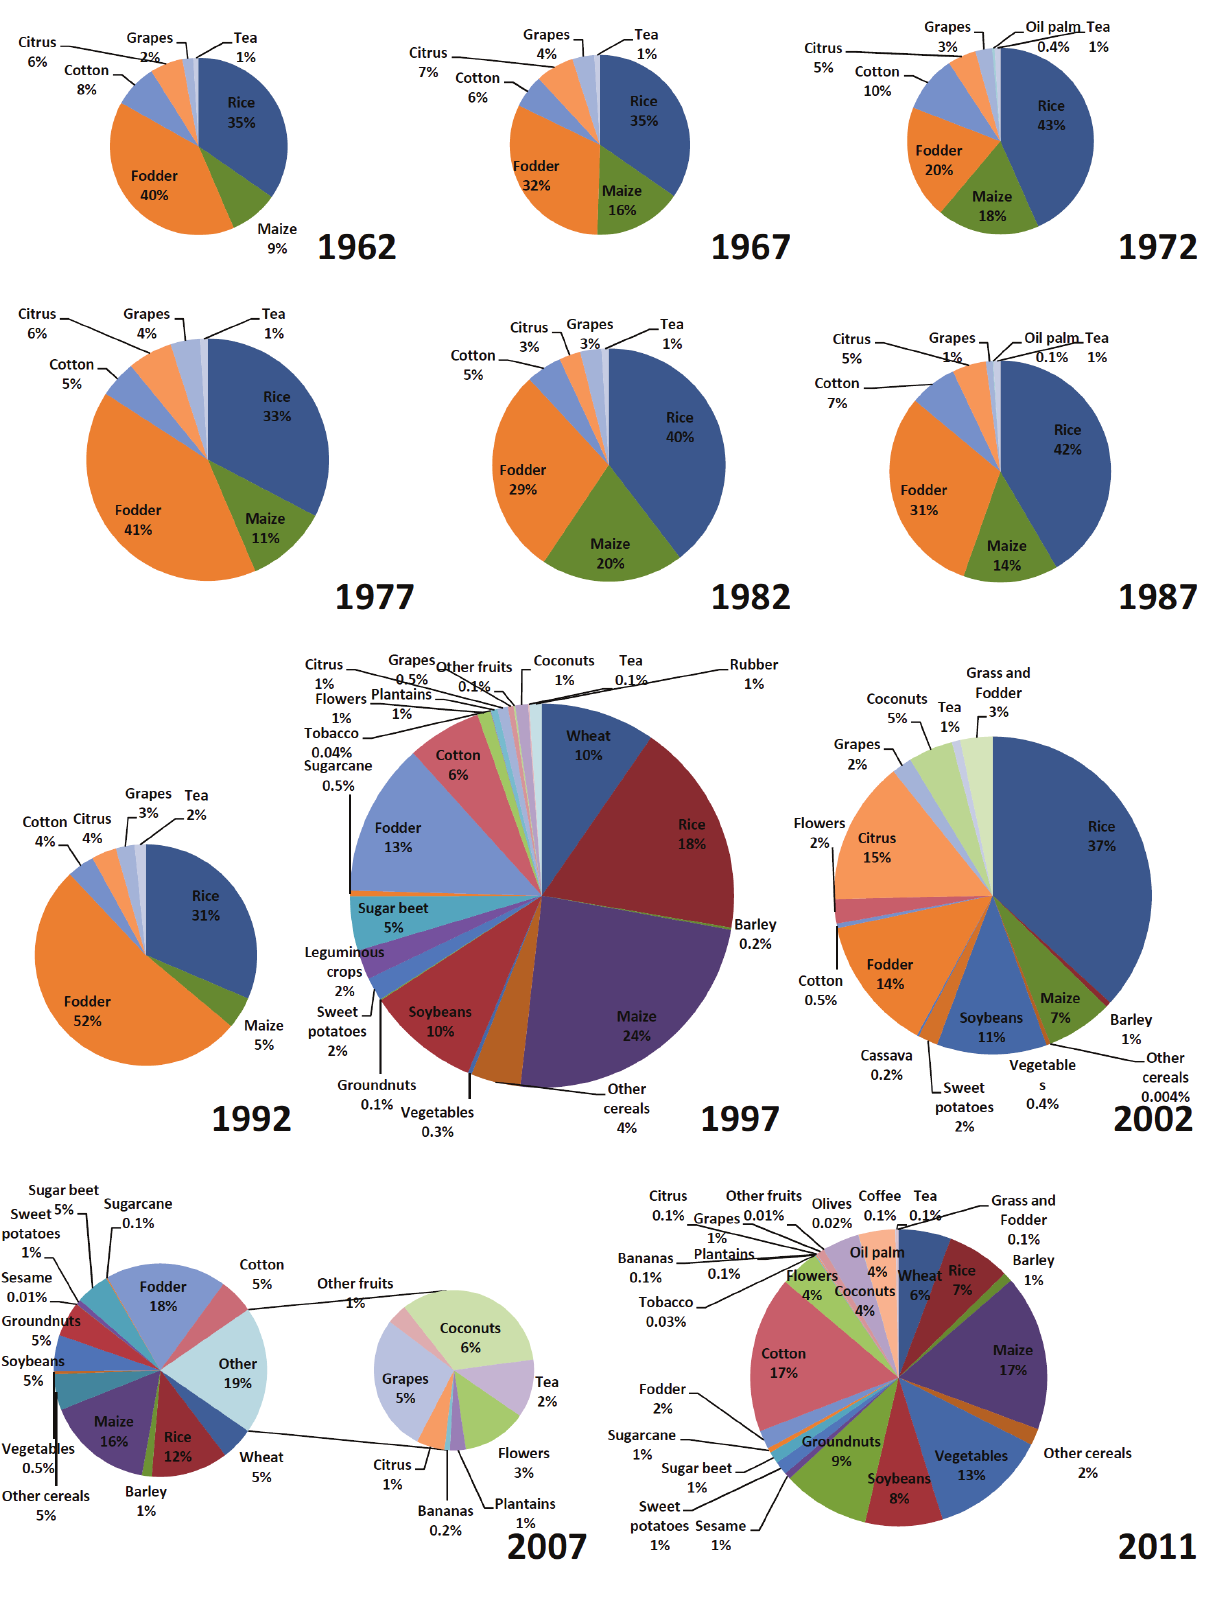
Figure 16: Status of cropping intensity (equipped area) for Americas in the previous half of